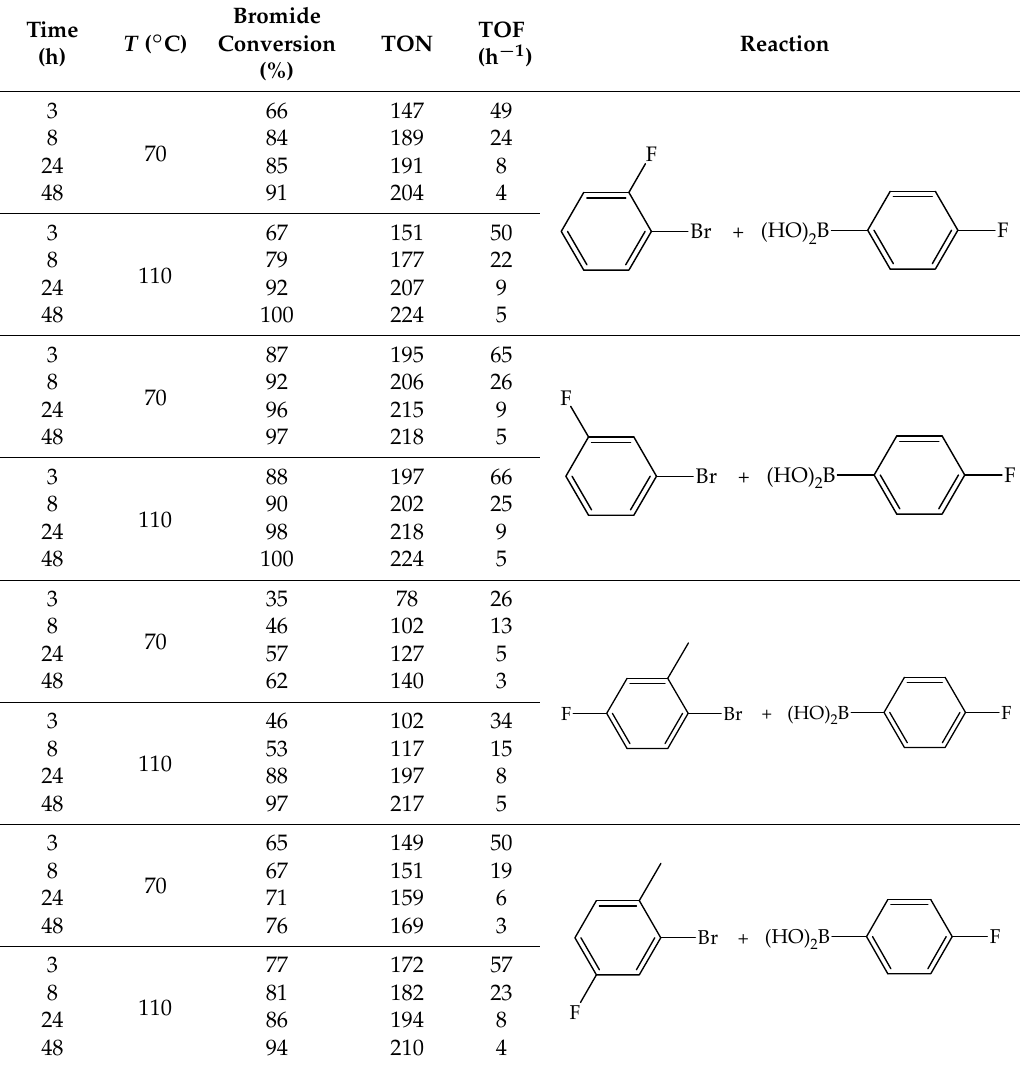
Table 3. Halide conversions in C ‐ C coupling reactions using 4 ‐ fluorophenylboronic acid and different fluorinated arylbromides catalyzed by G ‐ COOH ‐ Pd ‐ 10.